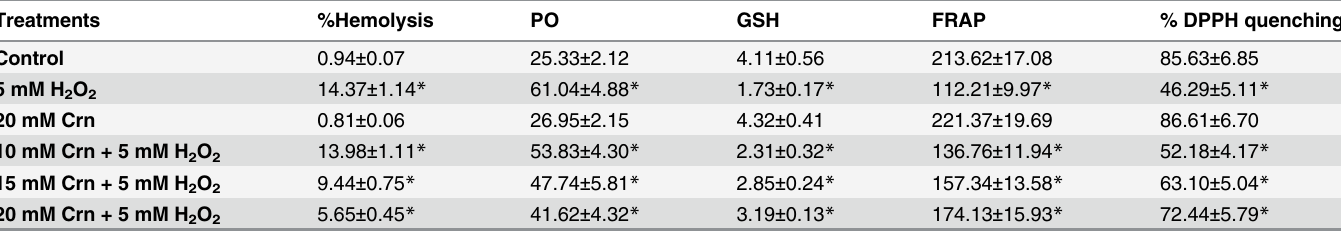
Table 3. Effect of creatinine on H 2 O 2 -induced changes in some erythrocyte parameters. Treatments